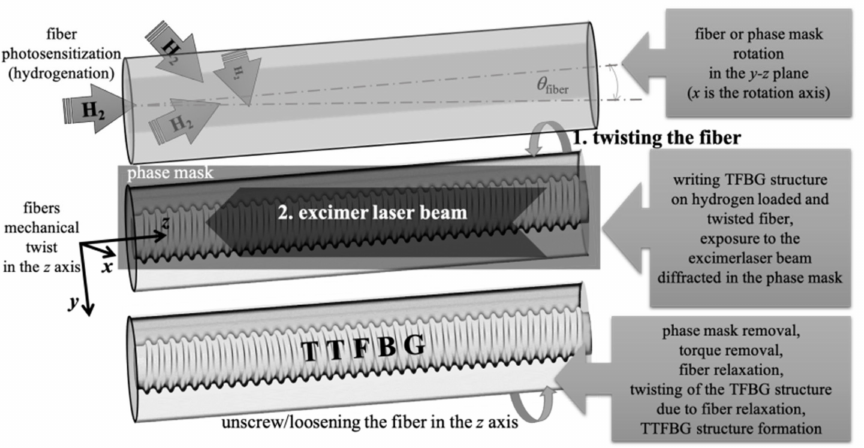
Figure 2. Scheme showing how the TTFBG structure is